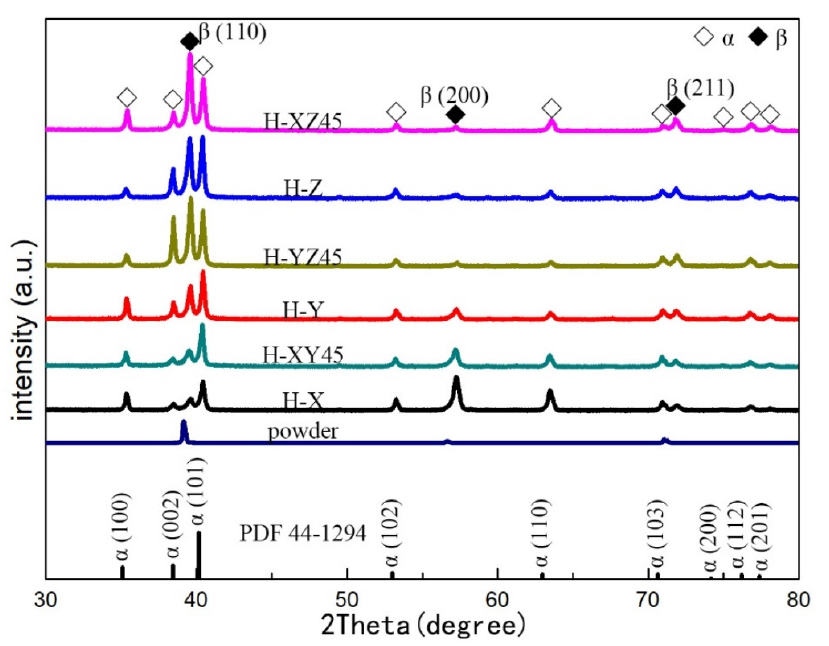
Figure 6. The XRD spectra of pre-alloy powder and aged samples of Ti-55511.